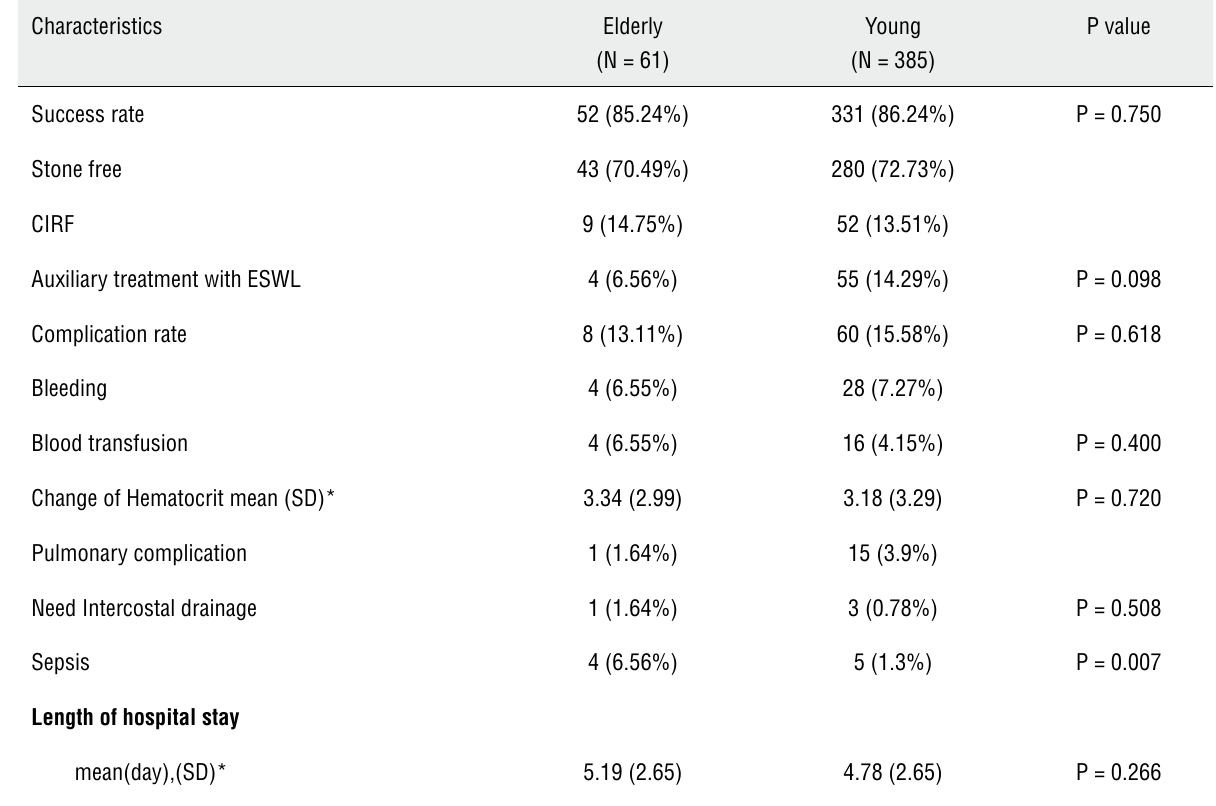
Table 4 - Outcome Characteristics.